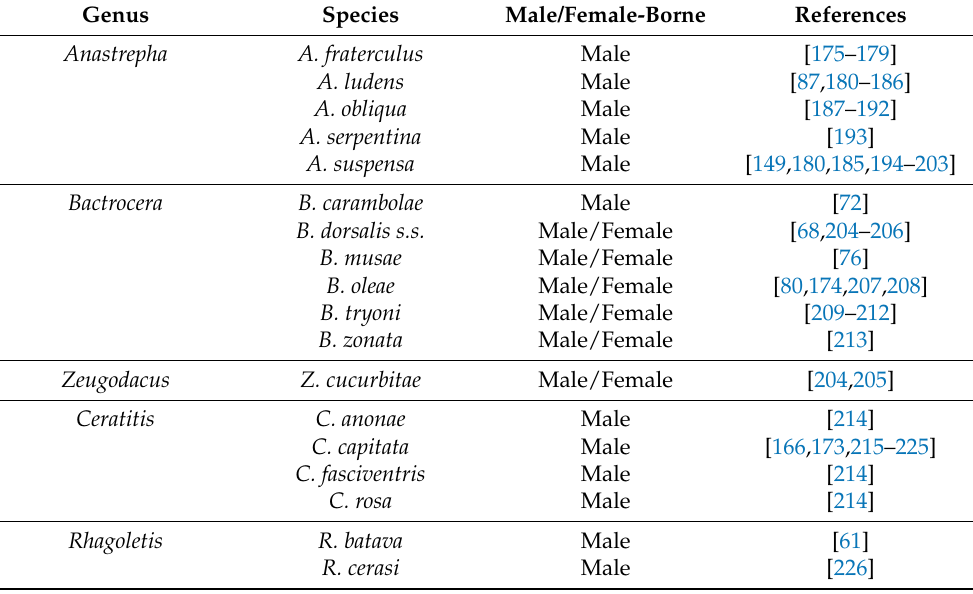
Table 1. List of tephritid species for which volatile pheromone has been chemically analysed from the headspace.